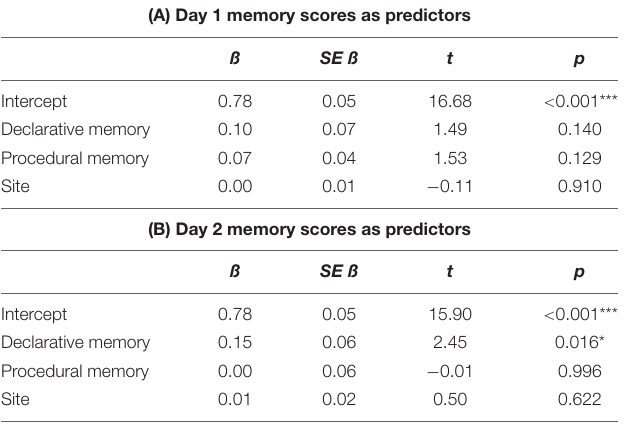
TABLE 3 | Results for multiple regression analysis of phonological awareness (PA)